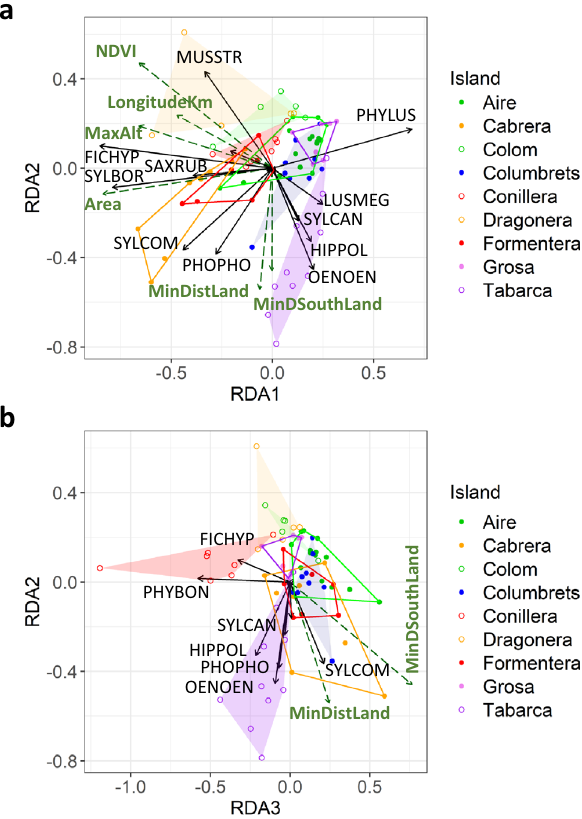
Figure 4. Triplot of the RDA relating migrant species composition to island variables. Each point corresponds to a spring migration year on one island. Pairs of islands located at similar longitude are depicted with the same color. Within each pair, points of the island with a more southern position are represented with a filled circle and hollow polygons and points of the island in the northern position with a hollow circle and shaded polygons. Dashed dark green arrows represent island variables significantly related to at least one of the axes represented (Table 5). Continuous black arrows represent the species most correlated to the axis (Table 4). The small unlabeled arrow in panel a corresponds to PHYSIB and in b corresponds to LUSMEG. Species acronyms identification in Supplementary Table S2. Figures were produced using R (R 3.6.1, https:// www.R- proje ct. org).